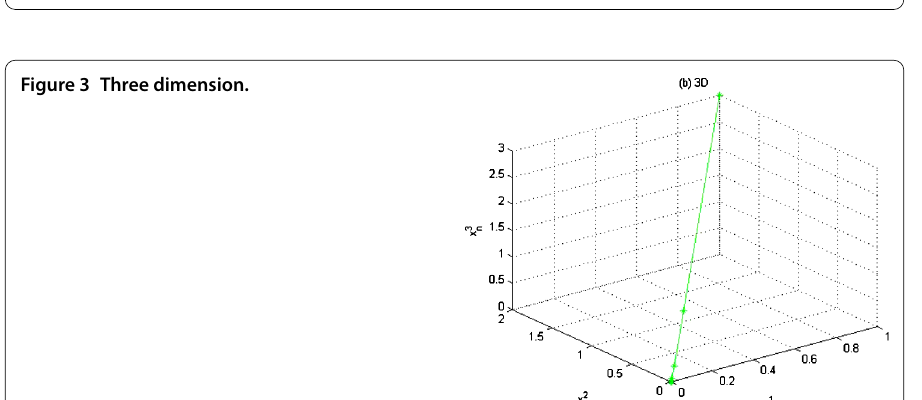
Figure 2 Two dimension.